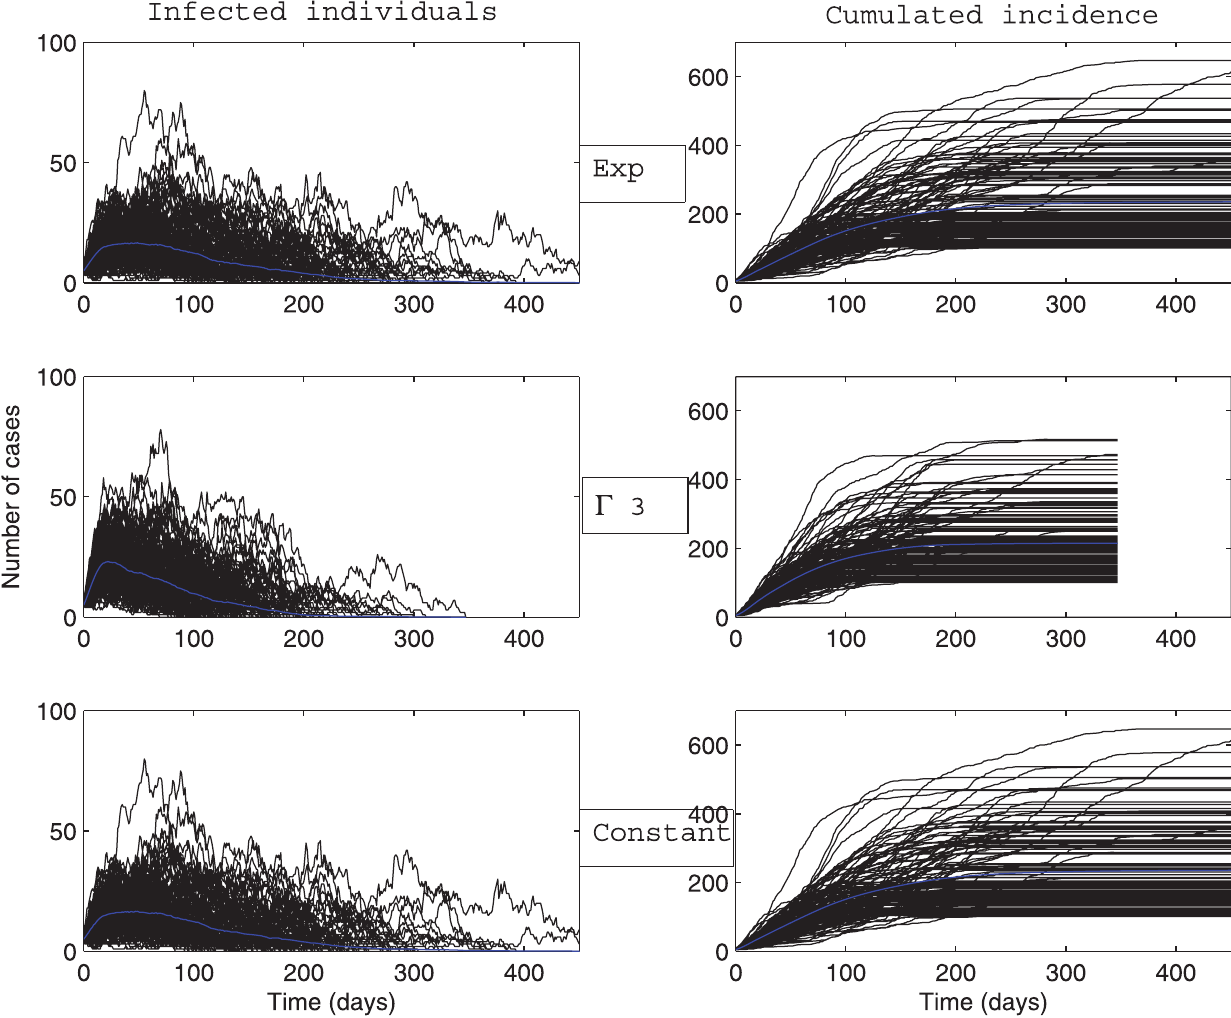
Figure 5. Dynamics of global number of cases and cumulative incidence described by a stochastic metapopulation model based on a scale-free network with mean degree of connectivity equal to 10. Early extinct trajectories were not considered. The mean (blue curve) was calculated over major epidemics only (corresponding to a final attack rate greater than 5 % ). Simulations are performed using a time-continuous event-driven approach with T I * Exp( c ) (top panel), T I * C (3,3 c ) (middle panel) and T I ~ Const ~ 1 = c (bottom panel). Parameters values are given in the subsection Examples of Results.